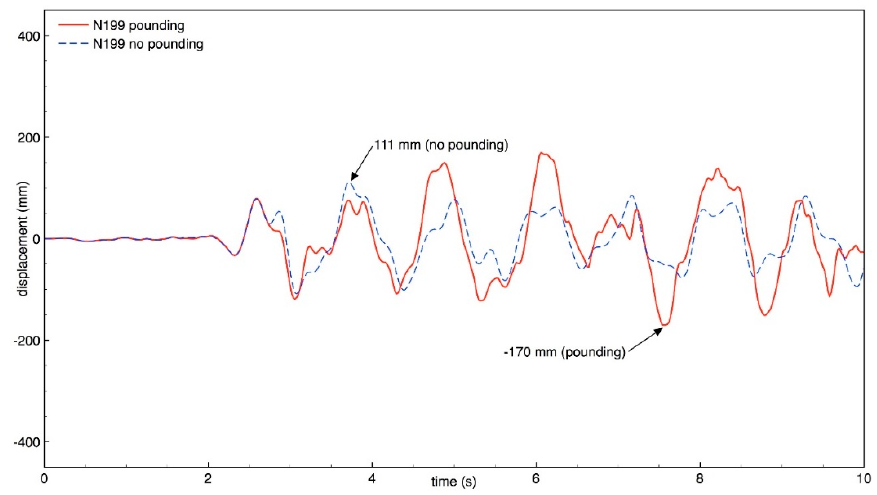
Figure 21. Transverse response of building A (node N199) with and without pounding.